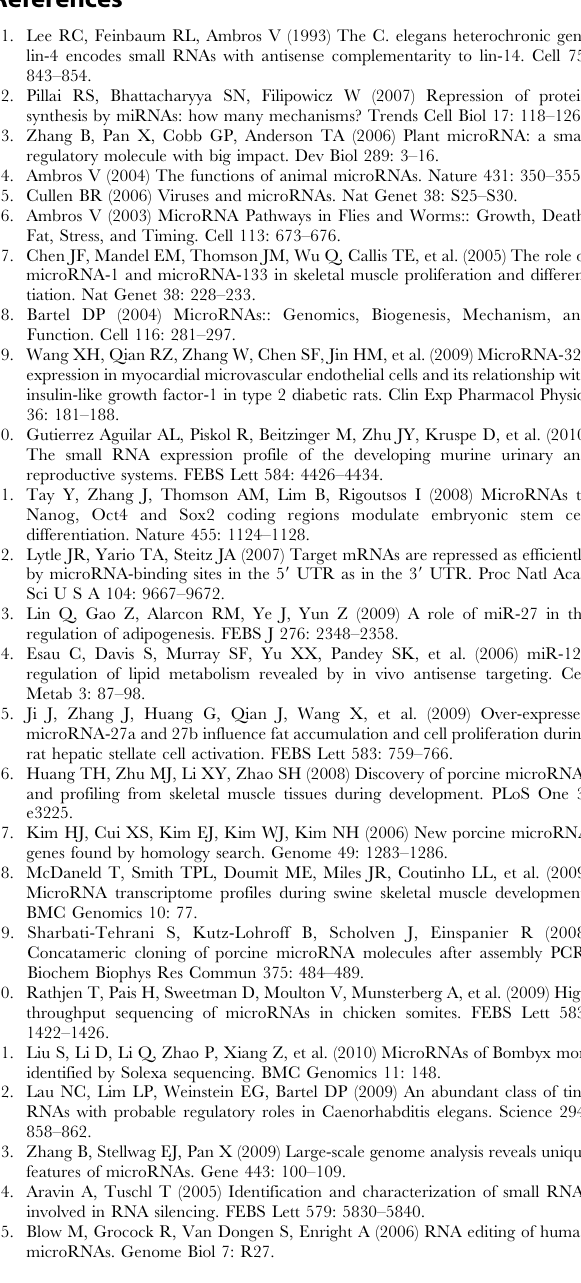
Table S6 Clustered miRNAs in porcine backfat tissue. (XLS) Table S7 Conserved porcine miRNAs from vertebrates to invertebrates. (XLS) Table S8 The mature miRNA sequences and primer sequences of stem-loop